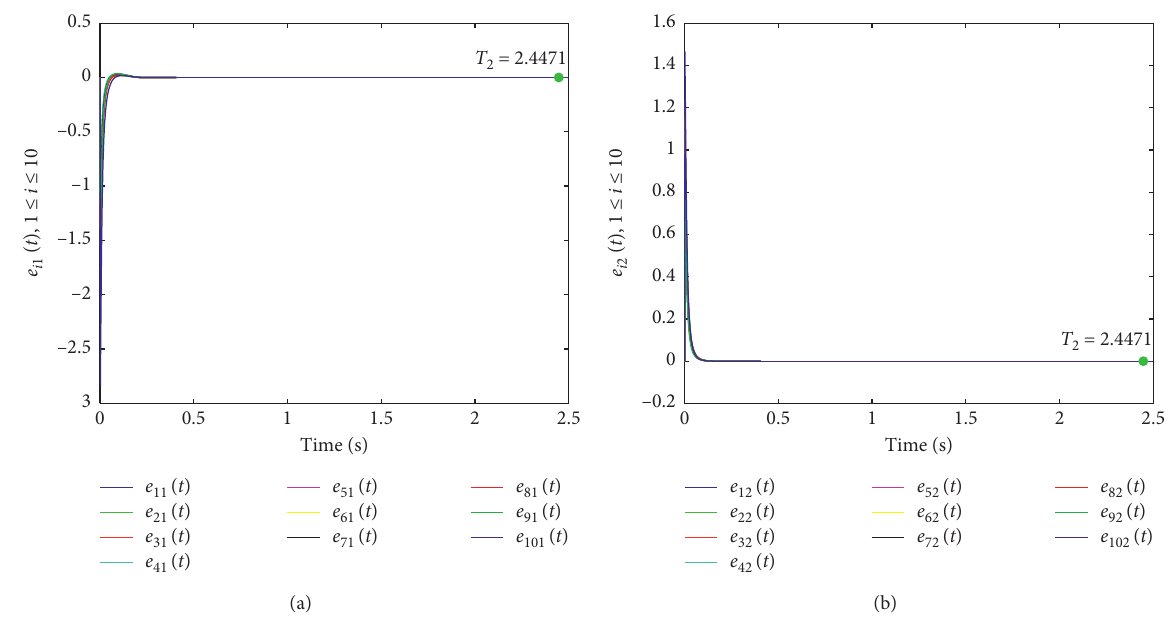
Figure 4: The synchronization errors between systems (35) and (36) by controller (25). (a) e